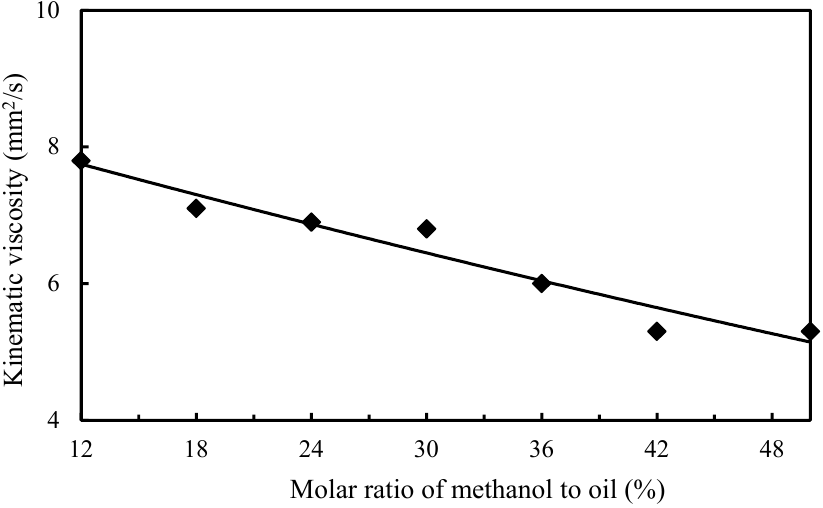
Molar ratio of methanol to oil